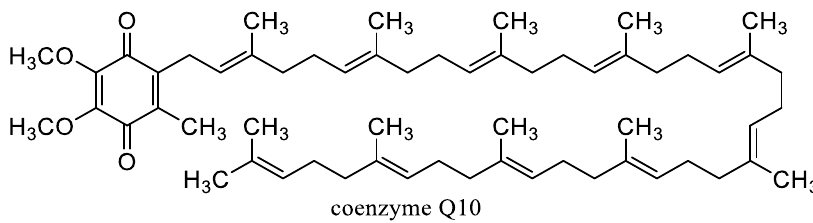
Figure 4. Structure of coenzyme Q10.